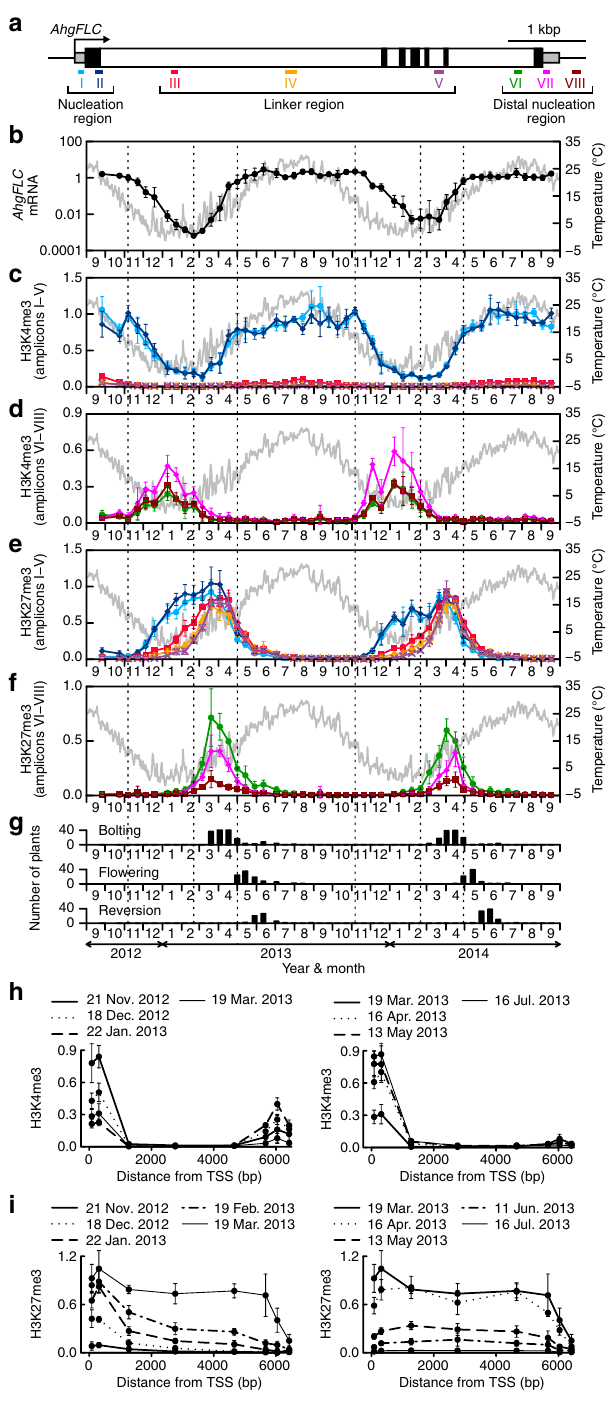
Fig. 1 Seasonal dynamics of AhgFLC mRNA and histone modi fi cation levels for 2 years in the natural habitat. a Structure of the AhgFLC locus with untranslated regions (grey), exons (black) and introns (white); distribution of eight H3K4me3 and H3K27me3 ChIP amplicons in different colours and the de fi nitions of the nucleation region, linker region, and distal nucleation region. b – f Relative quanti fi cation of the seasonal dynamics of AhgFLC mRNA ( b ), H3K4me3 at amplicons I – V ( c ), H3K4me3 at amplicons VI – VIII ( d ), H3K27me3 at amplicons I – V ( e ), and H3K27me3 at amplicons VI – VIII ( f ) in the natural population of A. halleri at 2-week intervals. The daily means of air temperature are plotted in grey. The colour code in c – f corresponds to that in a . g Flowering phenology of the study population (see Methods for the de fi nition of the stages). Reversion, leaf formation at the reproductive shoot apical meristem. h , i The H3K4me3 ( h ) and H3K27me3 ( i ) levels against the distance from TSS along the AhgFLC locus in the downregulation (left) and upregulation (right) phases of expression. The qPCR data of AhgFLC are represented relative to those of AhgACT2 (mRNA and H3K4me3) and AhgSTM (H3K27me3). The means and standard deviations of biological replicates are shown. n = 4 for mRNA, H3K4me3 and H3K27me3 at amplicons I – V. n = 3 – 4 (average, >3.9) for H3K4me3 and H3K27me3 at amplicons VI – VIII. For each replicate, a pool of leaves from ten plants (out of 40 plants) was analysed. Source data underlying Fig. 1b – g are provided as a Source Data fi le.